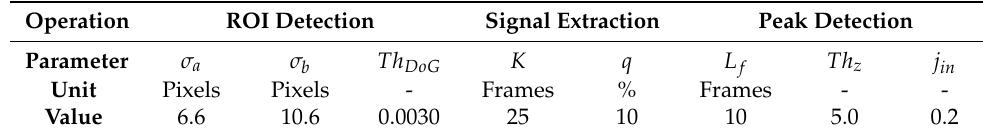
Table 2. The parameters used to test the processing speed of CALIMA 2.0 and detect physiological levels of calcium influx in primary rat cortical neurons in dataset 1 .